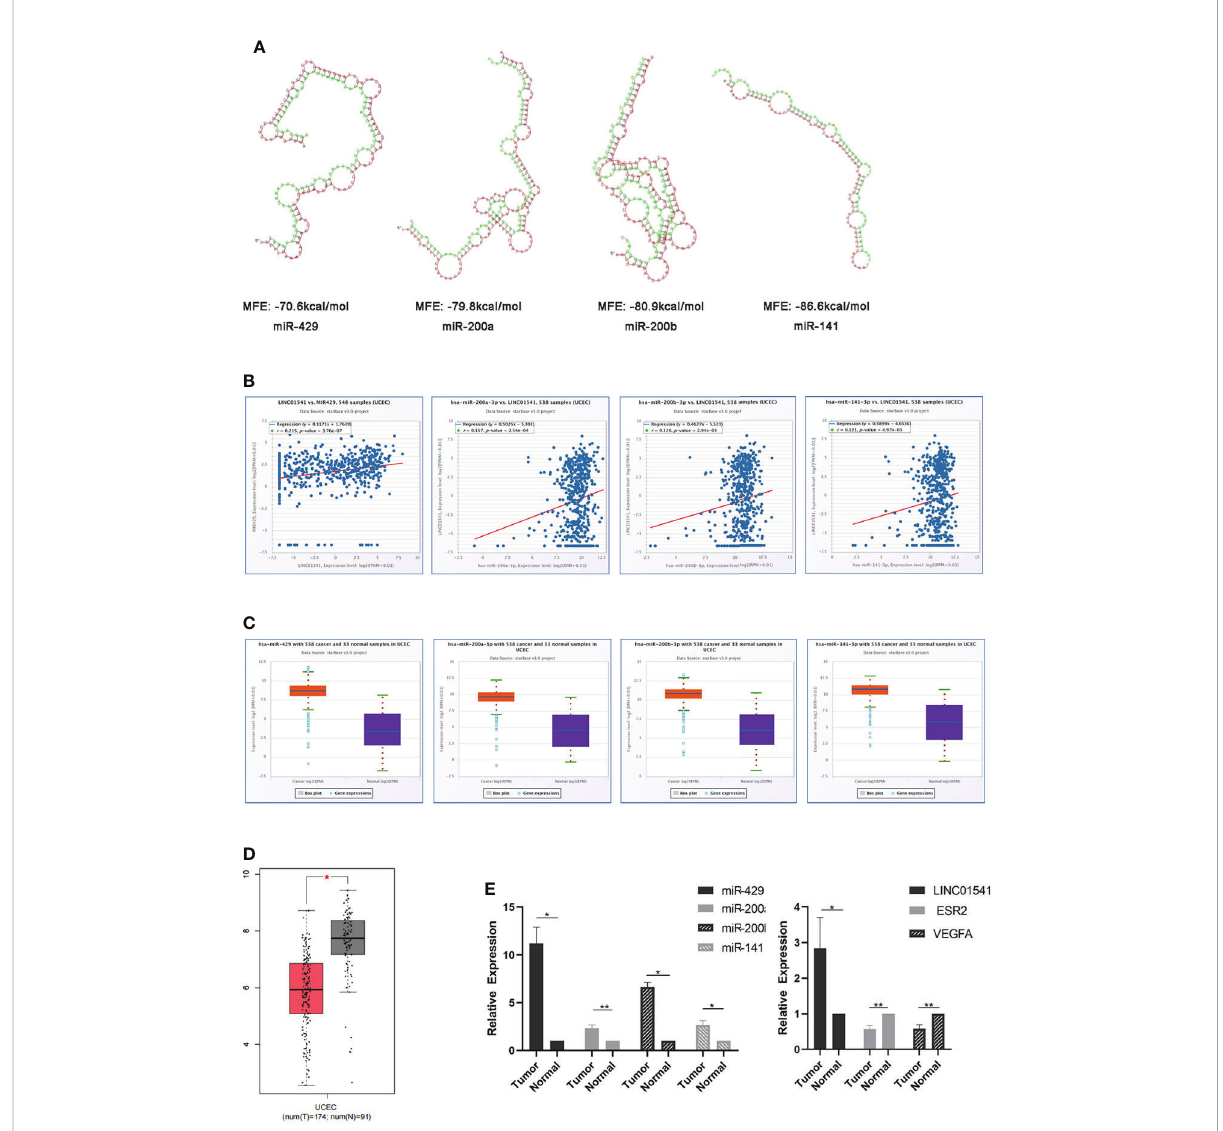
FIGURE 1 Bioinformatics prediction and the expression of related genes in EAC tissue specimens. (A) RNAhybrid software demonstrated that miR-429, miR-200a, miR-200b, and miR-141 can bind to LINC01541 (red: LINC01541; green: miRNAs). MFE = minimum free energy (the absolute value of which represents the binding degree of miRNA and target mRNA or lncRNA). (B) StarBase v3.0 demonstrated a positive correlation between miR-429 and LINC01541 in UCEC ( P <0.01). Other members of the miR-200s family also demonstrated this trend. (C) starBase v3.0 demonstrated increased expression of miR-200s (except miR-200c) in UCEC. (D) Boxplot demonstrating VEGFA transcriptional expression in UCEC and normal uterus tissues from GEPIA. The red boxes represent UCEC (n = 174); the gray boxes represent normal tissue (n = 91). The y- axis indicates the log2-transformed gene expression level. (E) The expression levels of LINC01541 and miR-200s in G1/G2 EAC tissues (n = 8) were signi fi cantly higher than those in normal tissue (n = 8); however, both ESR2 and VEGFA were decreased in EAC tissue. (* P <0.05; ** P